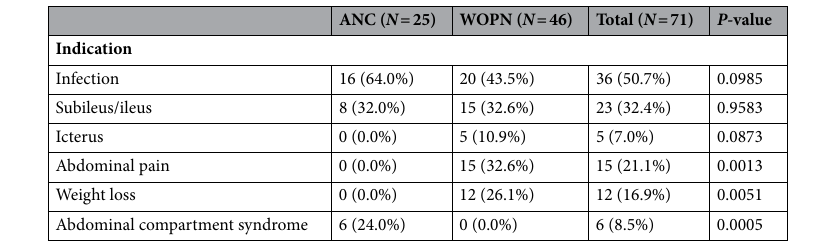
Table 2. Indications for endoscopic